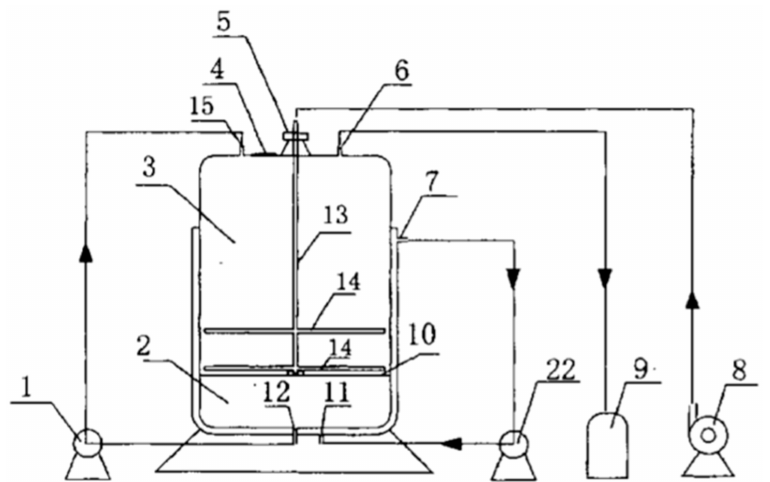
Figure 19. An anaerobic manual composter from CN1206189C [90], with details in Appendix A, Table